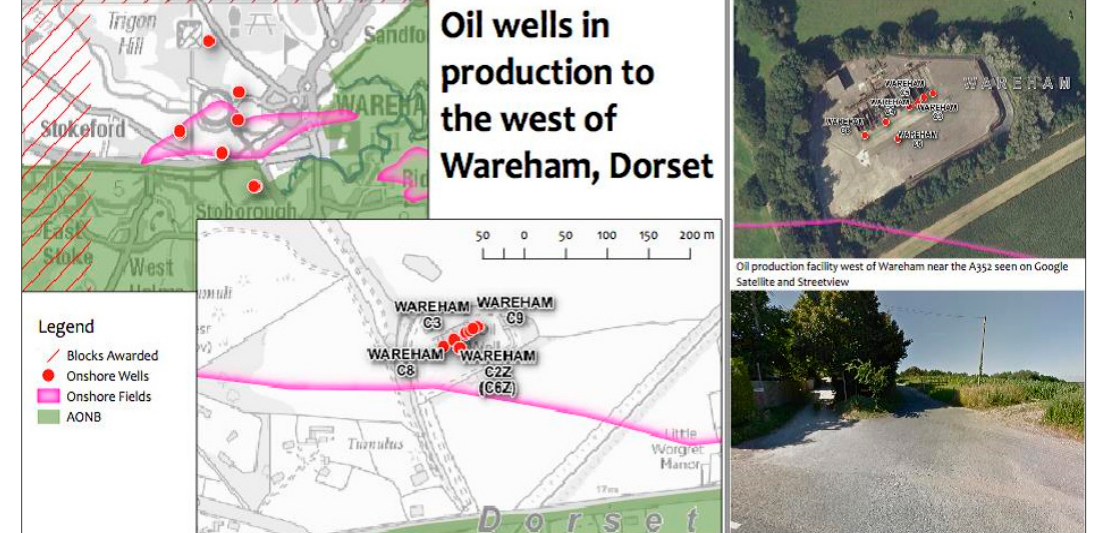
Figure 2. Using open source data in enquiry-based learning in QGIS.